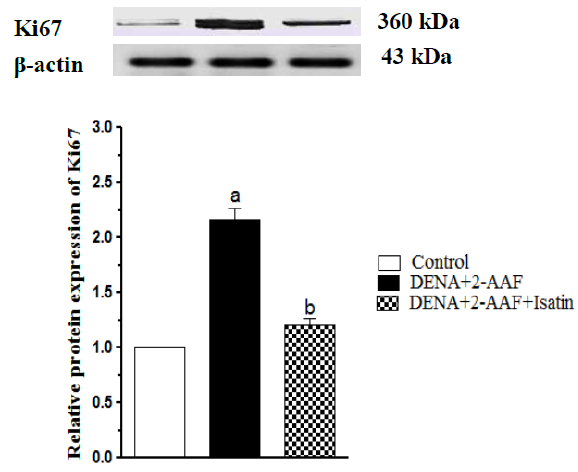
Figure 6. Isatin reduced Ki67 protein expression in DENA/2-AAF-treated rats. A typical Western blot is shown (upper panel). Data are presented as mean ± SEM. a p < 0.05 vs. control group. b p < 0.05 vs. DENA/2-AAF group. 3.7. Isatin Reversed the DENA/2-AAF-Induced Reduction in Liver Bcl2 Expression Administration of DENA/2-AAF significantly reduced hepatic expression of the anti- apoptotic factor Bcl2 compared to control rats ( p < 0.05), while isatin cotreatment reversed this effect (Figure 7).